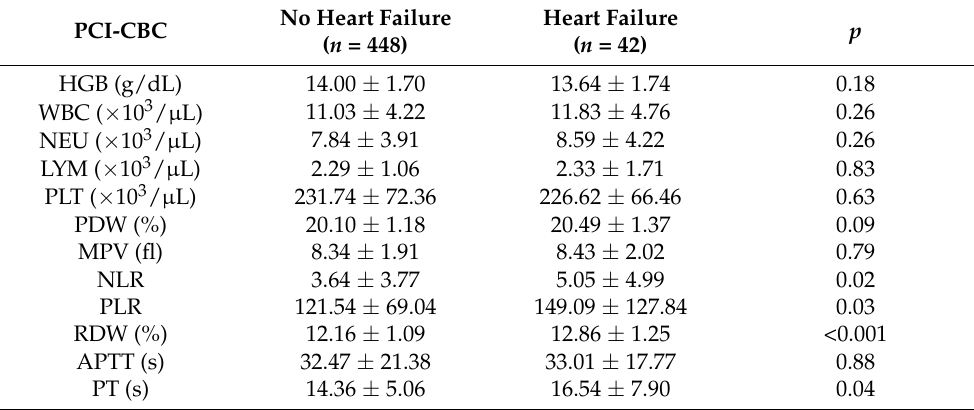
Table 14. Hematological and coagulation parameters of the groups with/without heart failure in PCI treated